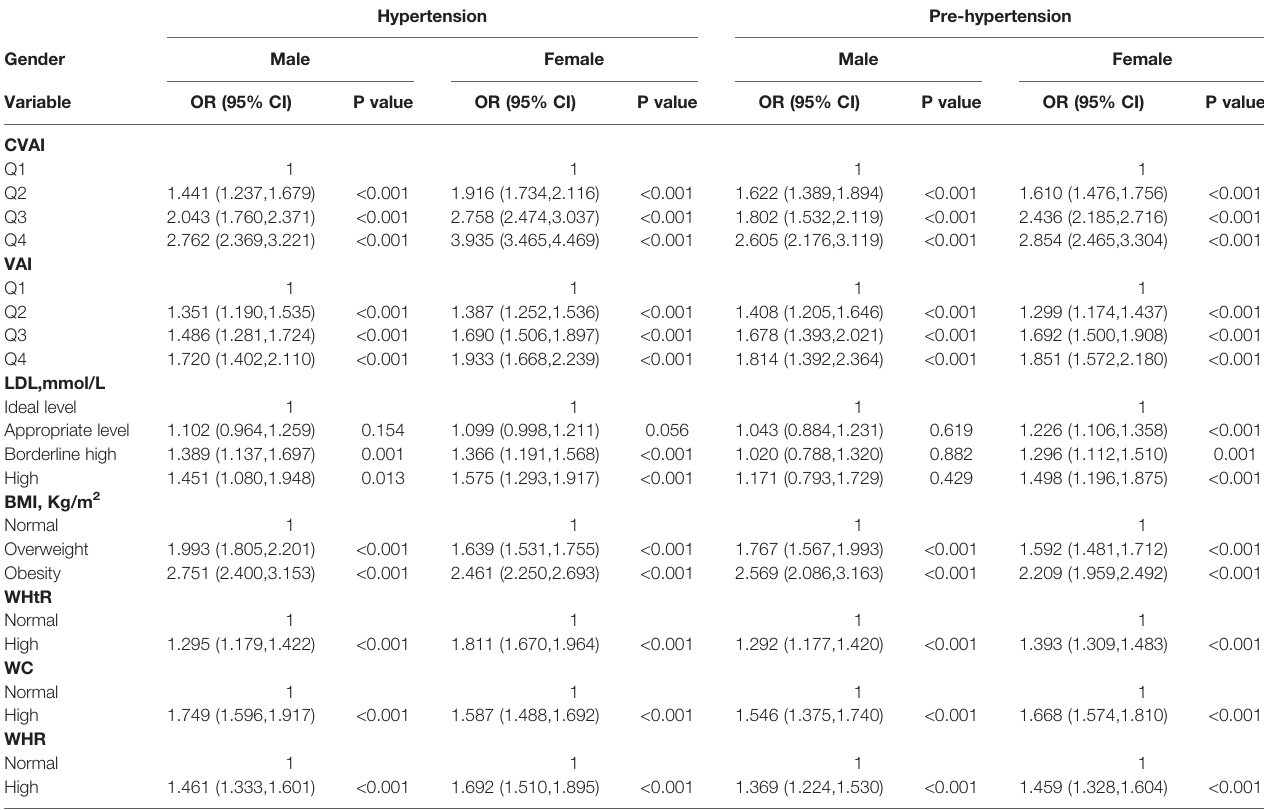
TABLE 3 | Association of the CVAI, VAI, BMI, WC, WHtR, WHR, LDL-C index with hypertension and prehypertension by